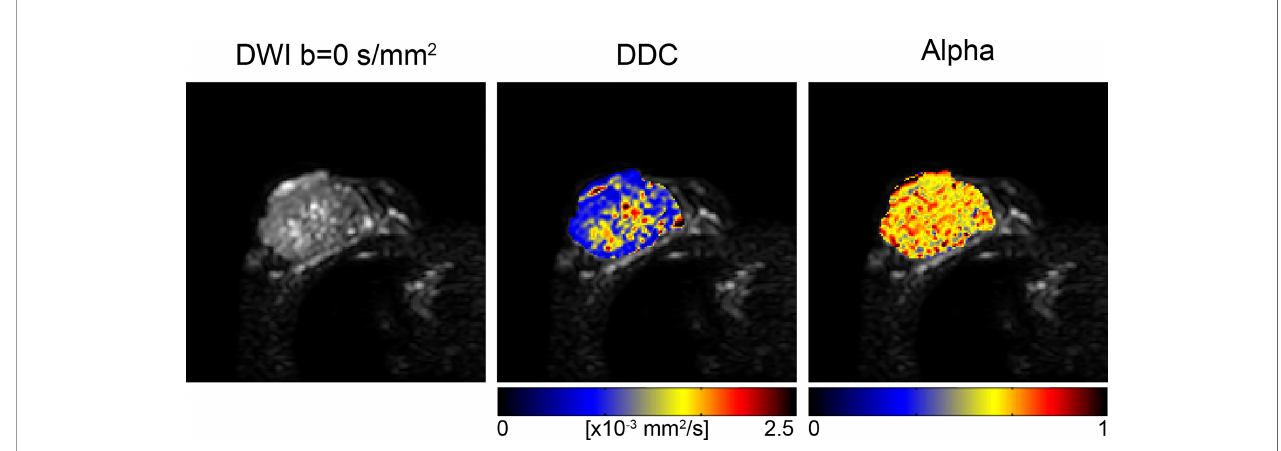
FIGURE 8 | Stretched exponential modeling with b-values of 0, 500, 1000, 1500 and 2000 s/mm 2 in a 73-year-old patient with invasive ductal carcinoma. Distributed diffusion coef fi cient (DDC) and alpha maps are overlaid on DWI b=0 s/mm 2 images, acquired at 3T (56). (Courtesy of Shiteng Suo, PhD, and Jia Hua,